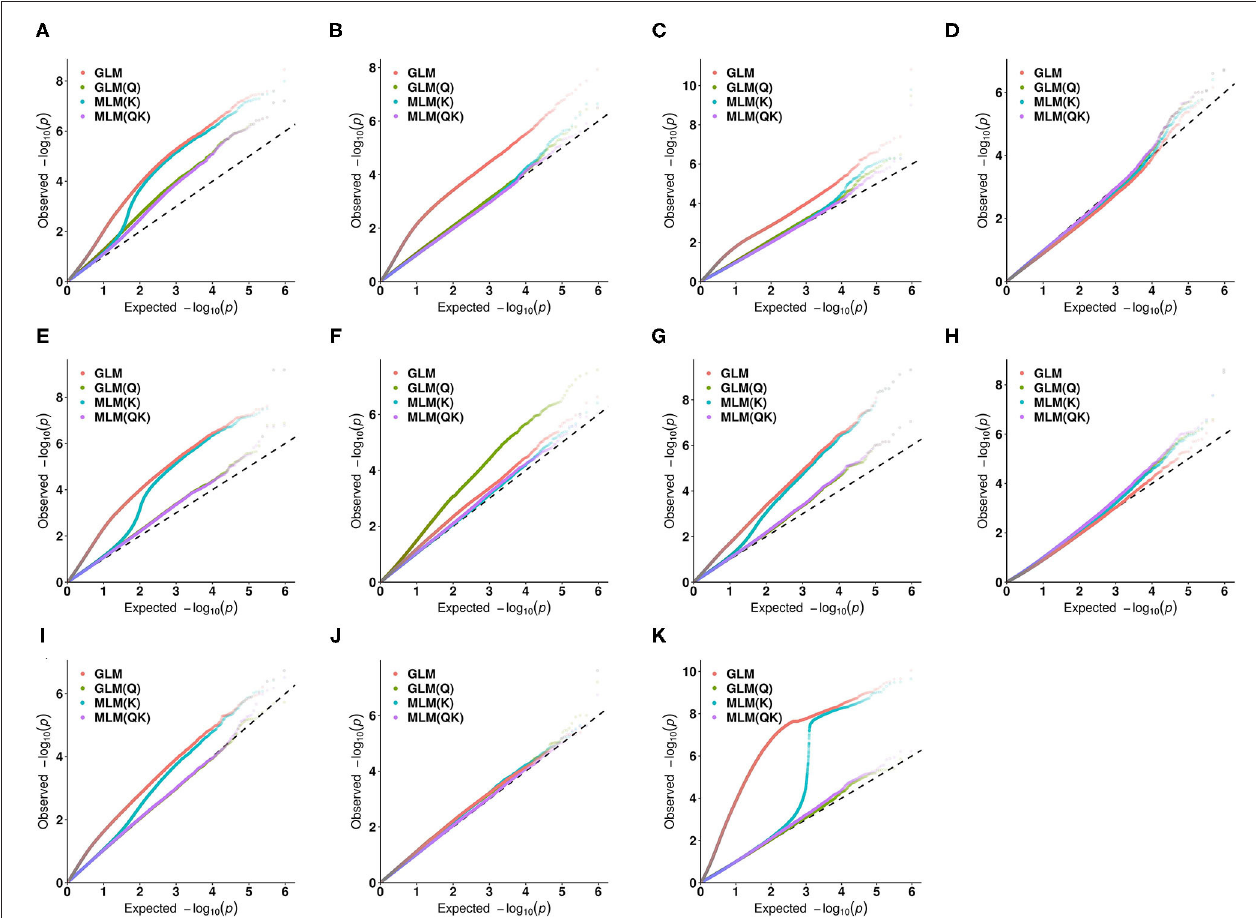
FIGURE 4 | Quantile-quantile (QQ) plots for the 11 quantitative traits under different association models. (A) the amount of pollen per flower; (B) the number of stamens per flower; (C) the corolla diameter; (D) the amount of pollen per flower; (E) the amount of pollen per anther; (F) pollen viability (PV); (G) the anthocyanin content of petal (ACP); (H) the ascorbic acid content of leaf (AL); (I) the total chlorophyll content of leaf (TCL); (J) the total phenol content of leaf (TPL); (K) the total flavonoid content of leaf (TFL).